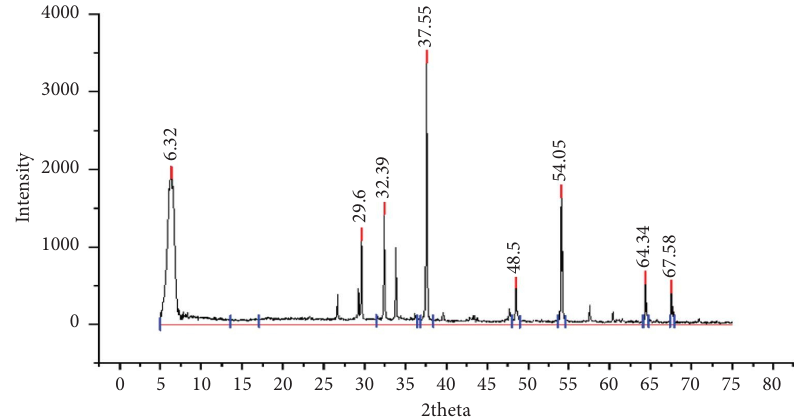
Figure 5: Te XRD form of calcium oxide powder calcined at a temperature of 900 ° C (own fgure).